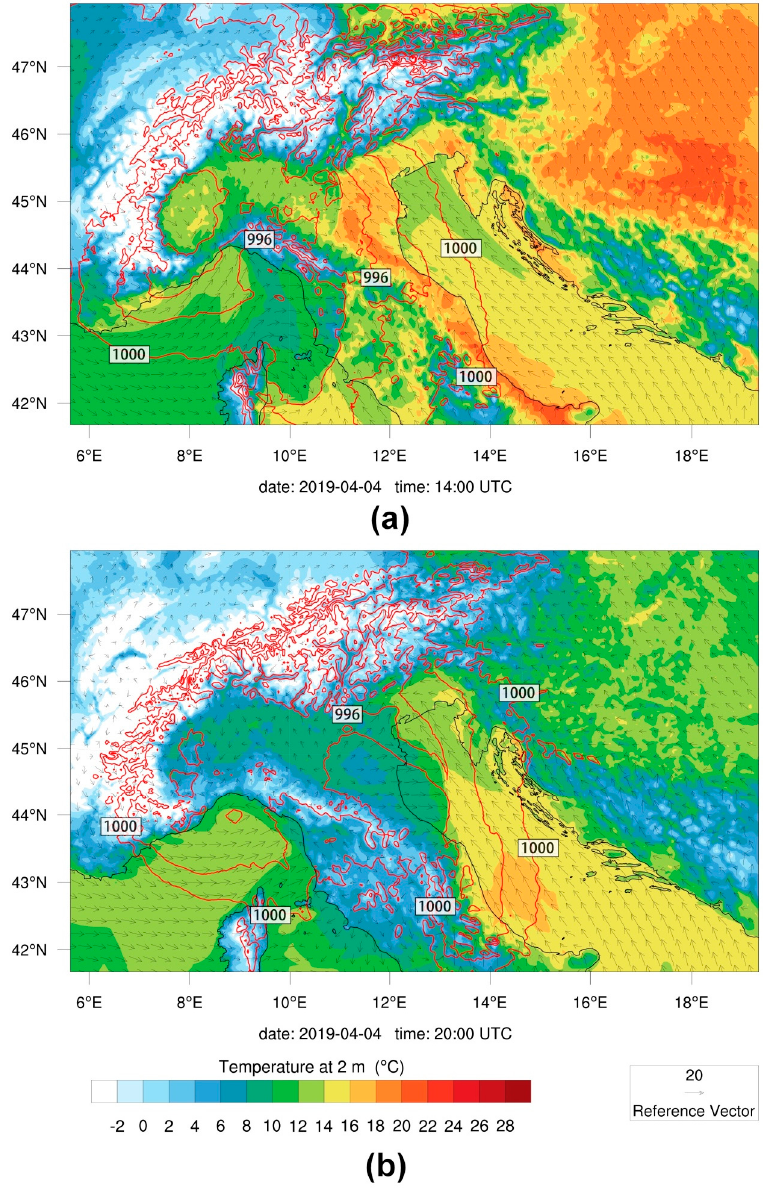
Figure 4. The 2 m temperature (colored scale), mean sea level pressure (red lines, in hPa) and sur- face wind vectors (m·s − 1 ) at 14:00 UTC, 4April 2019 (panel ( a )) and at 20:00 UTC, 4 April 2019 (panel ( b )). Run with data assimilation until 20:00 UTC,inner grid.